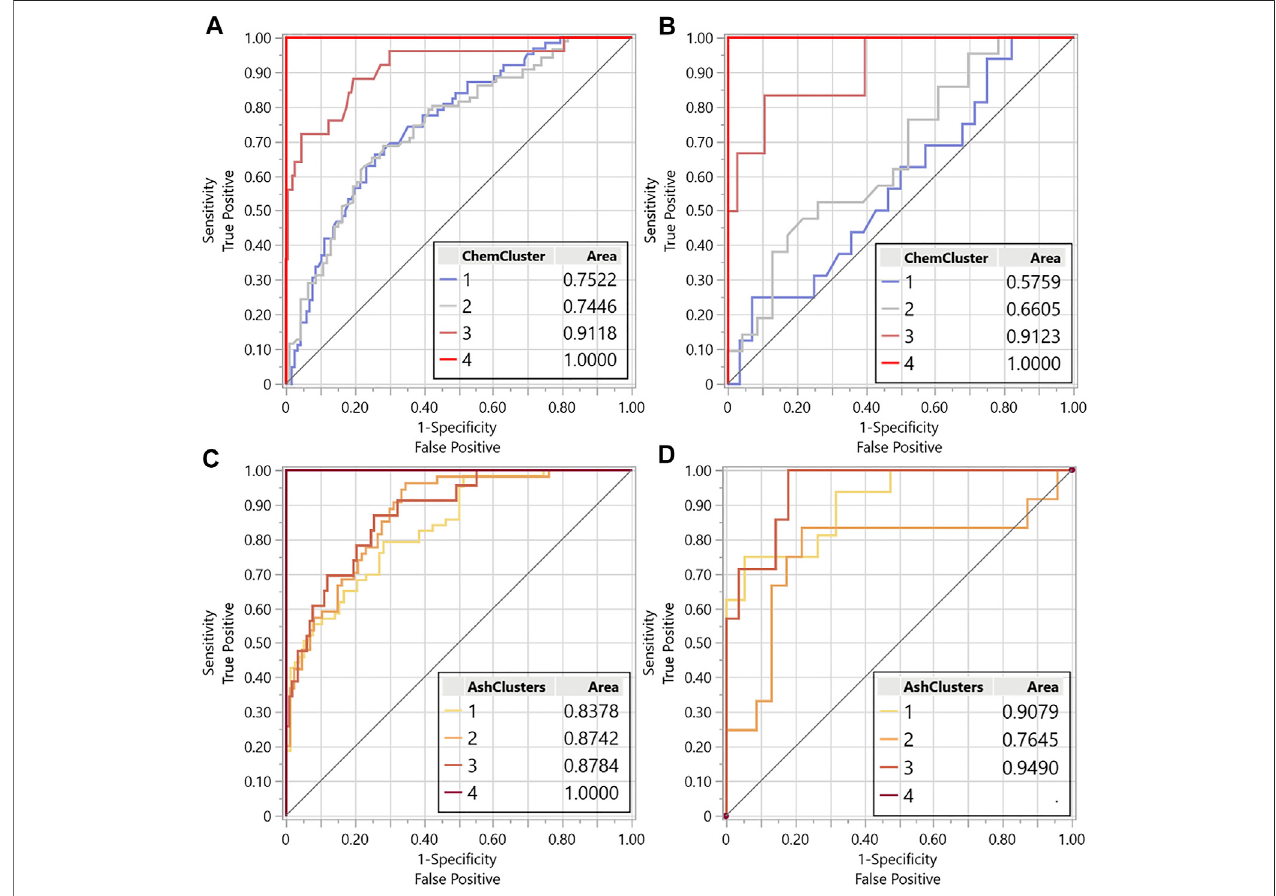
FIGURE 8 | Receiver operator characteristic (ROC) curves for the logistics regression training sets using image analysis data red, green, blue channels to predict the chemical cluster (associated with levels of biological degradation) (A) training set and (B) validation set and ash cluster (associated with levels of soil contamination) (C) training set and (D) validation set.